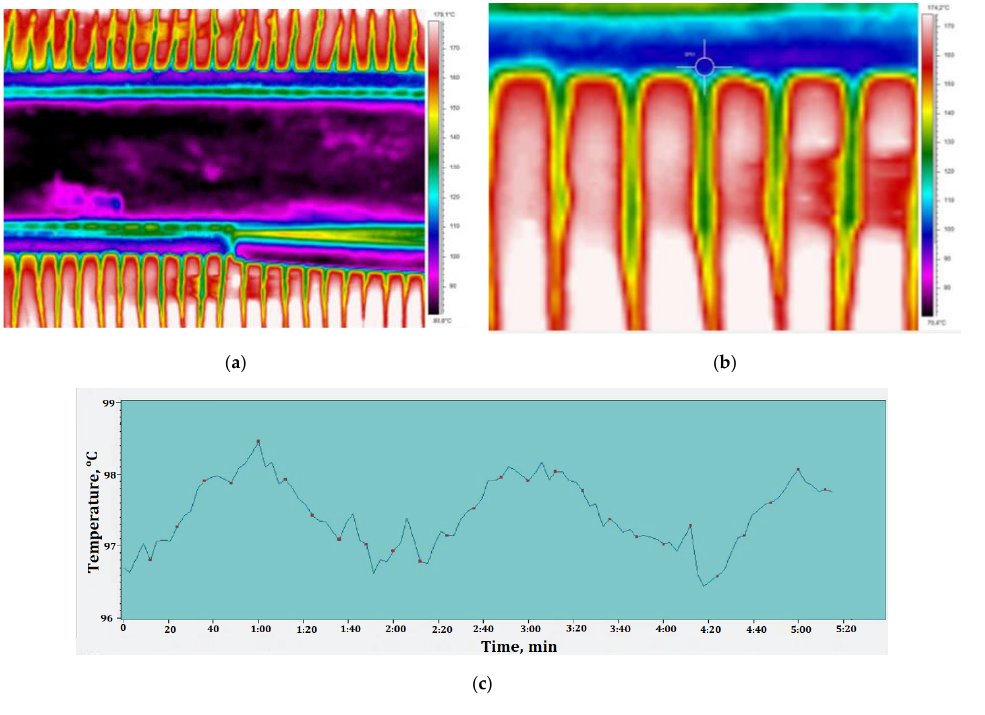
Figure 11. Results of the thermographic examinations of a laser-welded tube: ( a ) general thermogram of heat distribution in the tube, ( b ) detailed thermogram, and ( c ) temperature distribution at point SP01 for a period of 5.2 min.